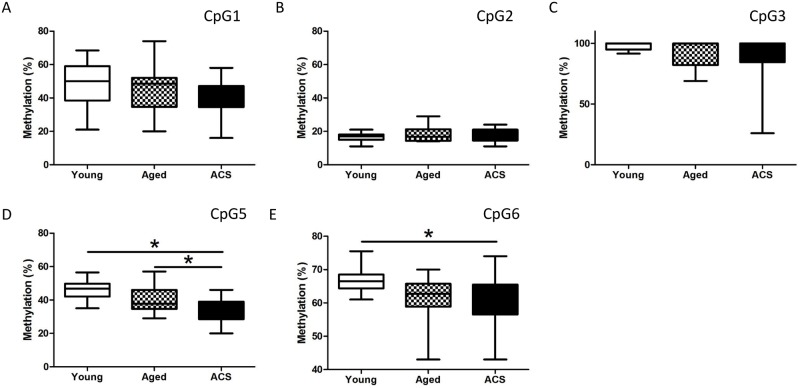
Hypomethylation of CpG5 and CpG6 in post-ACS patients.Methylation percentage of the methylation sites (A) CpG1, (B) CpG2, (C) CpG3, (D) CpG5 and (E) CpG6, previously identified in Fig 4. DNA was isolated from leukocytes of post-ACS patients (n = 21), age-matched (n = 12) and young (n = 14) healthy controls. Box and whiskers plot of (n) participants, *: p<0.05 (Kruskal-Wallis test).